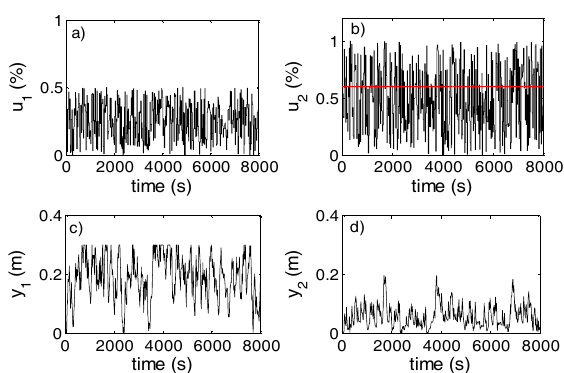
Figure 2. VRFT initial experiment data collection. Red line in ( b ) is the dead-zone threshold for u 2